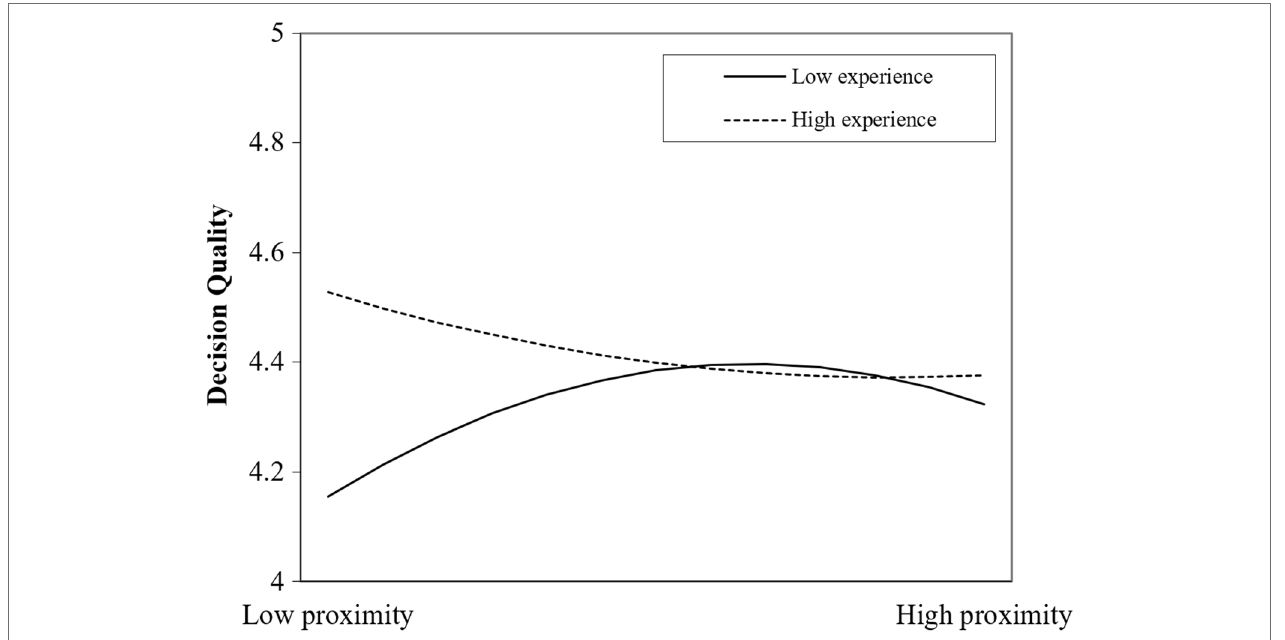
FIGURE 2 | Moderating effects of evaluation experience on cognitive proximity and decision